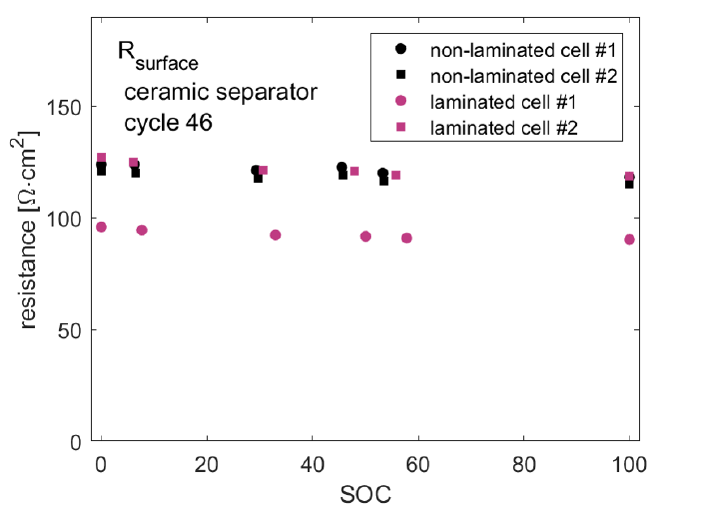
Figure 6. Surface resistance fit parameters (equivalent circuit fit analysis) for NMC 622—graphite single cells with ceramic separator, comparing non laminated and electrospun/laminated state. Any cell specific fit parameter datasets reveal negligible dependency of surface resis- tance with state of charge (SOC). While surface resistance fit parameters are well